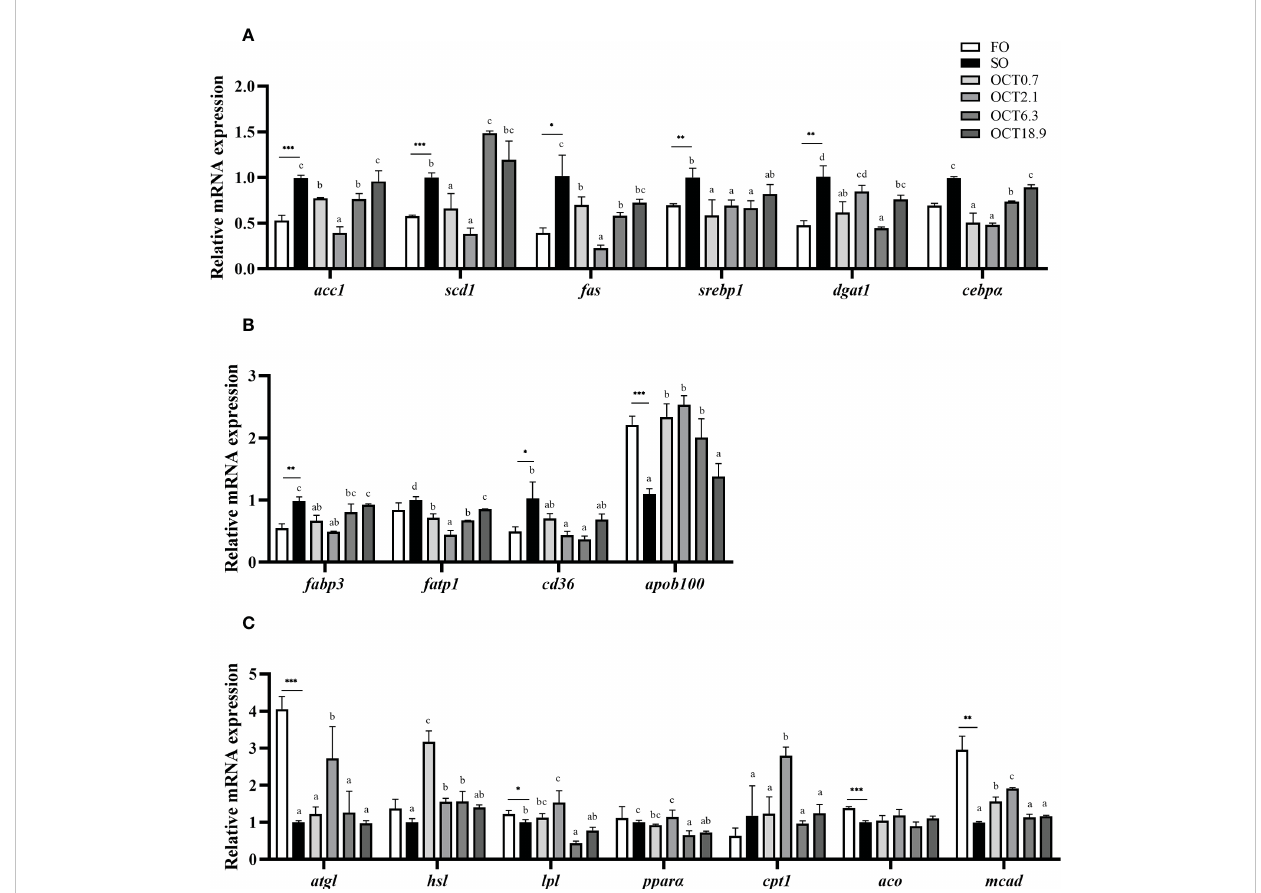
FIGURE 4 Effects of supplemental octanoate on the expression of lipid metabolism-related genes in the liver of large yellow croaker. (A) Lipogenesis, (B) FA transport, (C) Lipolysis and FA oxidation. Values were means (n = 3) with their standard errors represented by vertical bars. ∗ represent a signi fi cant difference of P < 0.05 between the SO group and the FO group. ∗∗ represent a signi fi cant difference of P < 0.01 between the SO group and the FO group. ∗∗∗ represent a signi fi cant difference of P < 0.001 between the SO group and the FO group. Different letters show signi fi cant difference ( P < 0.05) among OCT treatment groups. acc1 , acetyl CoA carboxylase 1; scd1 , stearoyl-coenzyme A desaturase 1; fas , fatty acid synthase; srebp1 , sterol-regulatory element binding protein-1; dgat1 , diacylglycerol acyltransferase 1; cebp a , CCAAT/enhancer binding protein a ; fabp3 , fatty acid binding protein 3; fatp1 , fatty acid transport protein 1; cd36 , cluster of differentiation 36; apob100 , apolipoprotein B 100; atgl , adipose triglyceride lipase; hsl , hormone-sensitive triglyceride lipase; ppar a , peroxisome proliferator-activated receptor a ; cpt1 , carnitine palmitoyl transferase 1; aco , acyl-CoA oxidase; mcad , medium chain acyl-CoA dehydrogenase. Polynomial analysis in (A) : acc1 : P Linear = 0.479, P Quadratic = 0.000; scd1 : P Linear = 0.000, P Quadratic = 0.000; fas : P Linear = 0.006, P Quadratic = 0.000; srebp1 : P Linear = 0.194, P Quadratic = 0.002; dgat1 : P Linear = 0.001, P Quadratic = 0.002; cebp a : P Linear = 0.856, P Quadratic = 0.000. Polynomial analysis in (B) : fabp3 : P Linear = 0.926, P Quadratic = 0.000; fatp1 : P Linear = 0.003, P Quadratic = 0.000; cd36 : P Linear = 0.002, P Quadratic = 0.001; apob100 : P Linear = 0.539, P Quadratic = 0.000. Polynomial analysis in (C) : atgl : P Linear = 0.985, P Quadratic = 0.003; hsl : P Linear = 0.044, P Quadratic = 0.000; lpl : P Linear = 0.003, P Quadratic = 0.013; ppar a : P Linear = 0.001, P Quadratic = 0.088; cpt1 : P Linear =